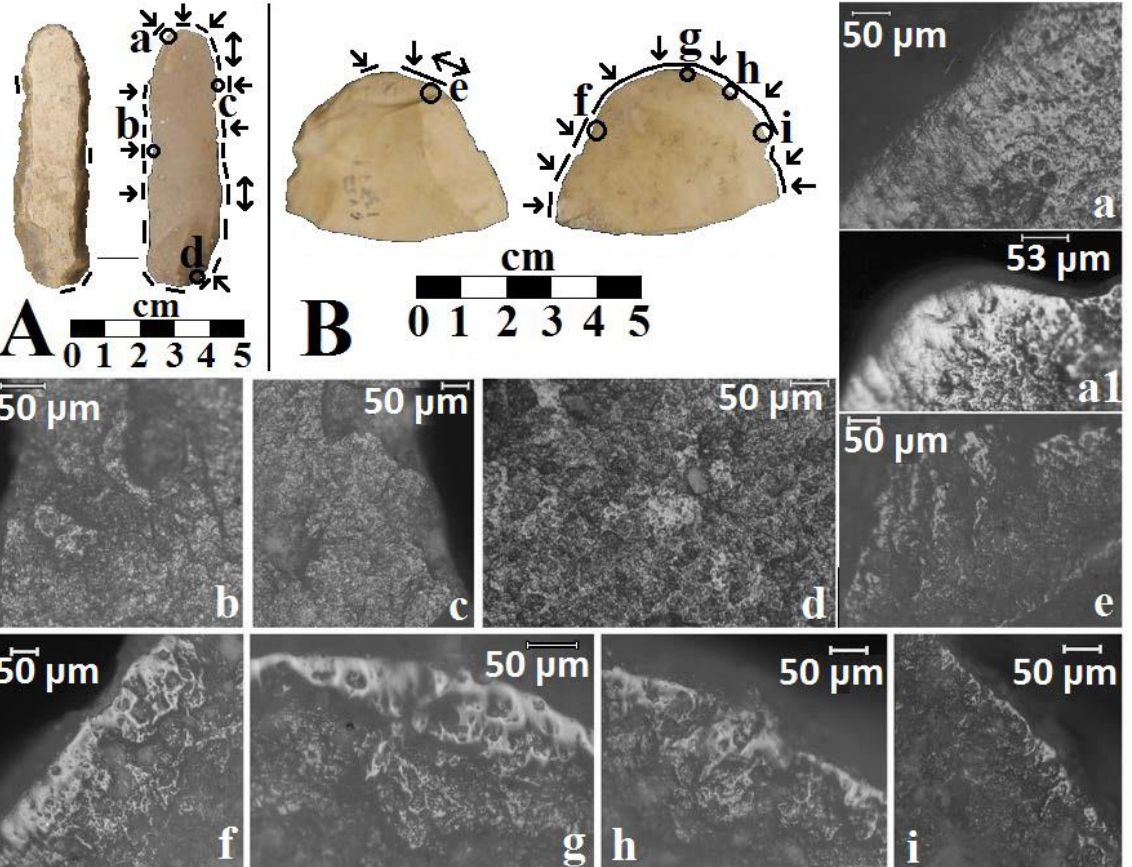
Figure 7. EBA fan scrapers ( A , B ) from Ein Zippori with microwear from scraping and cutting hides with thick fat layers. a , d : severe edge-rounding, striations, and well-developed, bright hide polish on A . a1 : wear traces on experimental scraper van Gijn (1990: fig. 13b) used on hide with powdered ochre and liver. b , c : duller rough “greasy” fresh hide or meat wear on A . e - i : “hide-ochre” polish similar to a1 on B . A : Dorsal (left) and ventral (right) faces of elongated FCFS fan scraper (MW#17) Area E, EBA layer, Locus 3041, Bucket 30125. B : Oval CFS fan scraper fragment (MW#22) Area B, EBA layer, Locus 1468, Bucket 13771. White lines: extent of usewear, arrows show orientation of microwear polishes and striations, circles: locations of microphotographs a- i . Photomicrographs are 187.5x and scales are 50 microns, except for a1 where scale is 53 microns, and magnification is